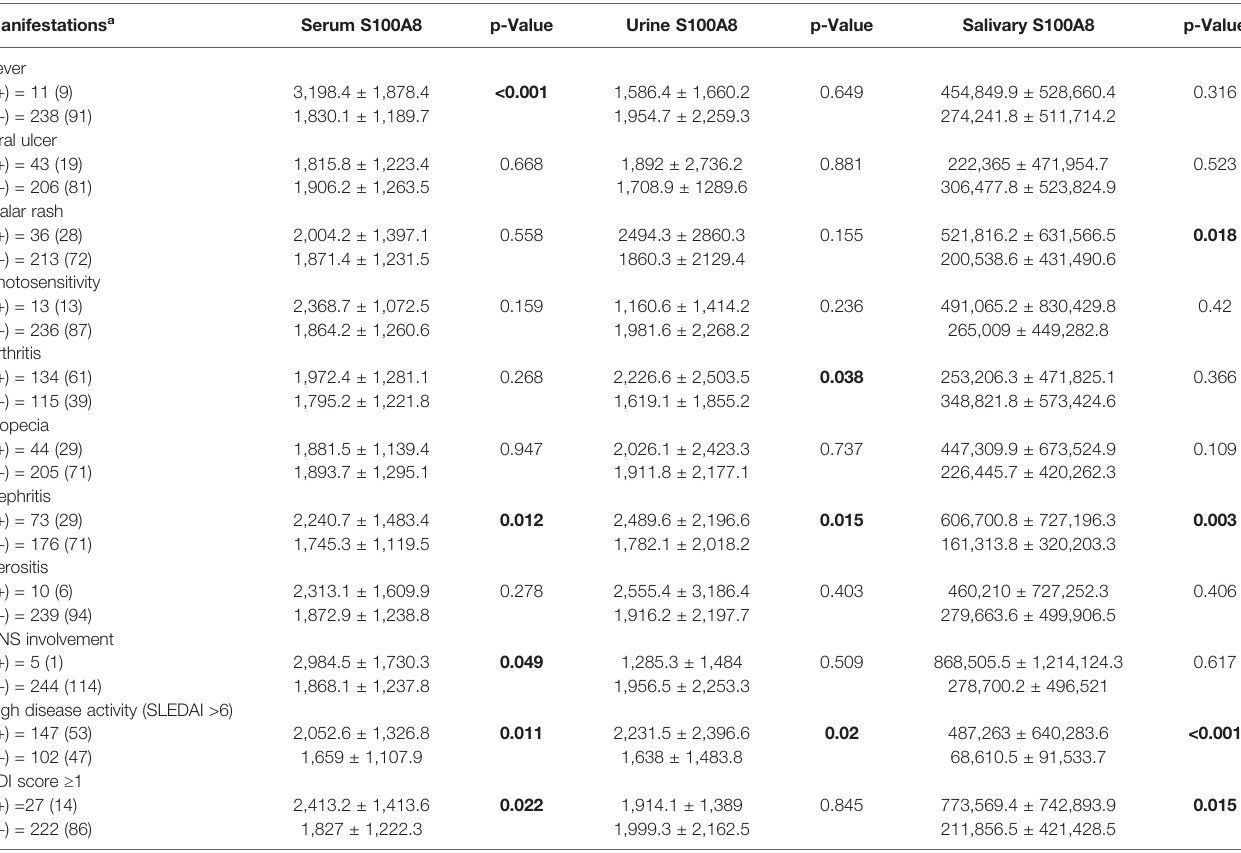
Bold values indicate signi fi cant p-values. SLE, systemic lupus erythematosus; CNS, central nervous system; SLEDAI, SLE disease activity index; SDI, Systemic Lupus International Collaborating Clinics/American College of Rheumatology Damage Index. a The number of patients in S100A8 is in